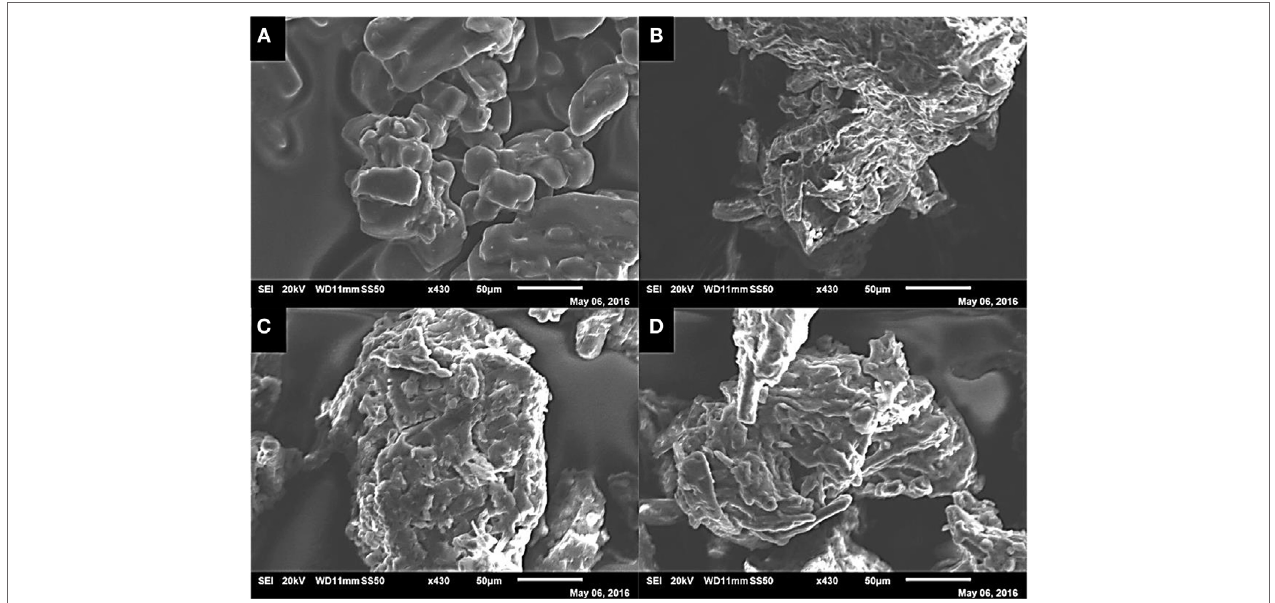
FigUre 7 | SEM images of unsupported [N 4444 ][Ac] (a) , powdered cellulose (b) , 75 wt% cellulose [N 4444 ][Ac] (c) , and 95 wt% cellulose [N 4444 ][Ac] (D) under the same degree of magnification ( × 430) at 20